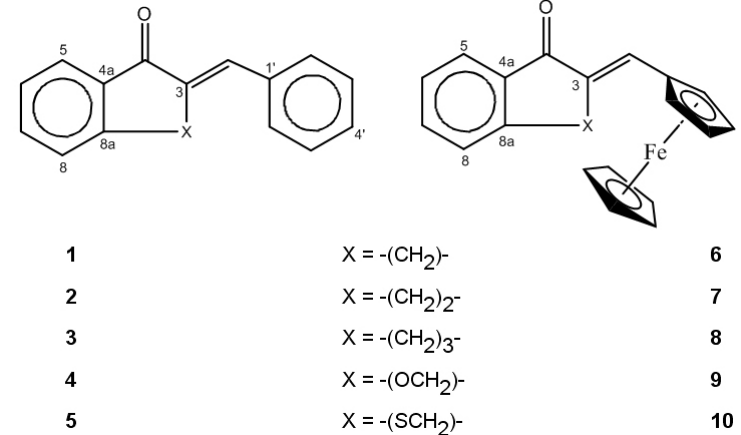
Figure 1. Structure of the investigated